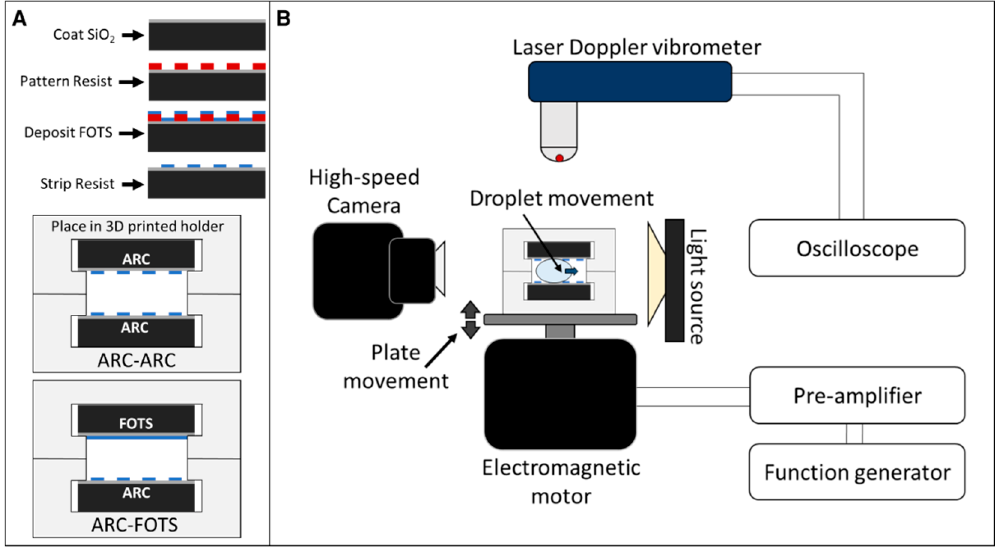
Figure 2. Fabrication process and experimental set-up. Anisotropic ratchet conveyors (ARCs) are fabricated by patterning resist on an oxidized silicon wafer, and coating exposed regions with a hydrophobic silane. ( A ) Stripping the resist reveals the hydrophilic ARC pattern. Wafers are diced into plates and secured in a 3D printed holder. ( B ) Droplet transport is examined by driving this system with an electromagnetic motor and function generator. The acceleration of the driving vibration is measured with a laser Doppler vibrometer and droplet motion is recorded with a high-speed camera.